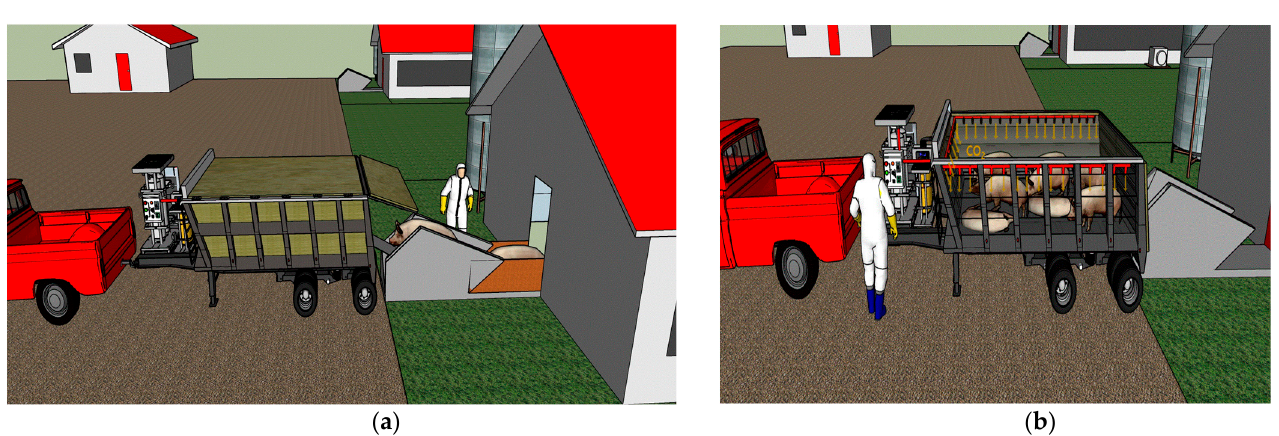
Figure 6. Mobile CO 2 vaporizer system for on ‐ site depopulation. ( a ) Loading the pigs. ( b ) Depopulation with liquid CO 2 vaporizing under closed hatch cover.